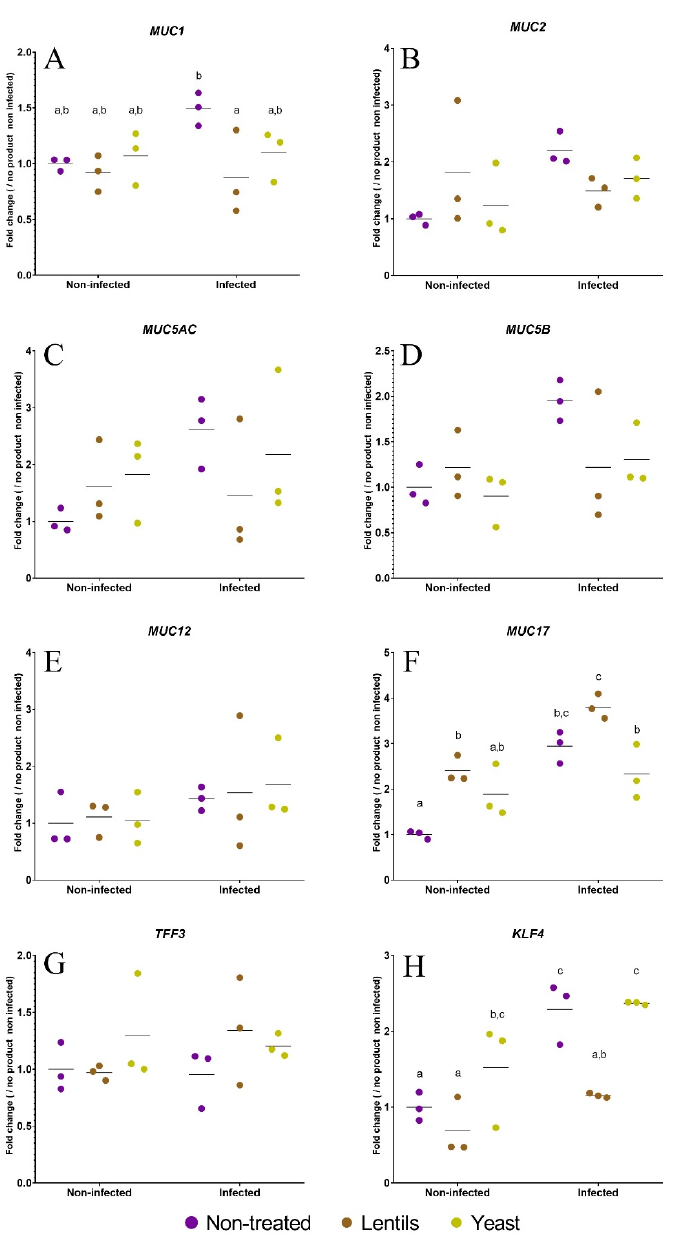
Figure 6. Modulation of mucus-related gene expression by fiber-containing products. Caco-2/HT29- MTX cells were infected with the ETEC strain H10407 (10 7 CFU·mL − 1 , MOI 100) after a 3 h pre-treat- ment with the lentil extract (brown dots, ‘lentils’) or specific yeast cell walls (yellow dots, ‘yeast’). Non-infected and non-treated conditions (purple dots, ‘non-treated’) were used as control experi- ments. The expression of mucus-related genes ( MUC1 , MUC2 , MUC5AC , MUC5B , MUC12, MUC17, and TFF3 ) ( A – G ) and KLF4 (Kruppel-like factor 4), which is involved in goblet cell differentiation ( H ), were analyzed by RT-qPCR. The results are expressed as fold changes compared to the non- infected and non-treated control condition. The data represent the replicates of three independent